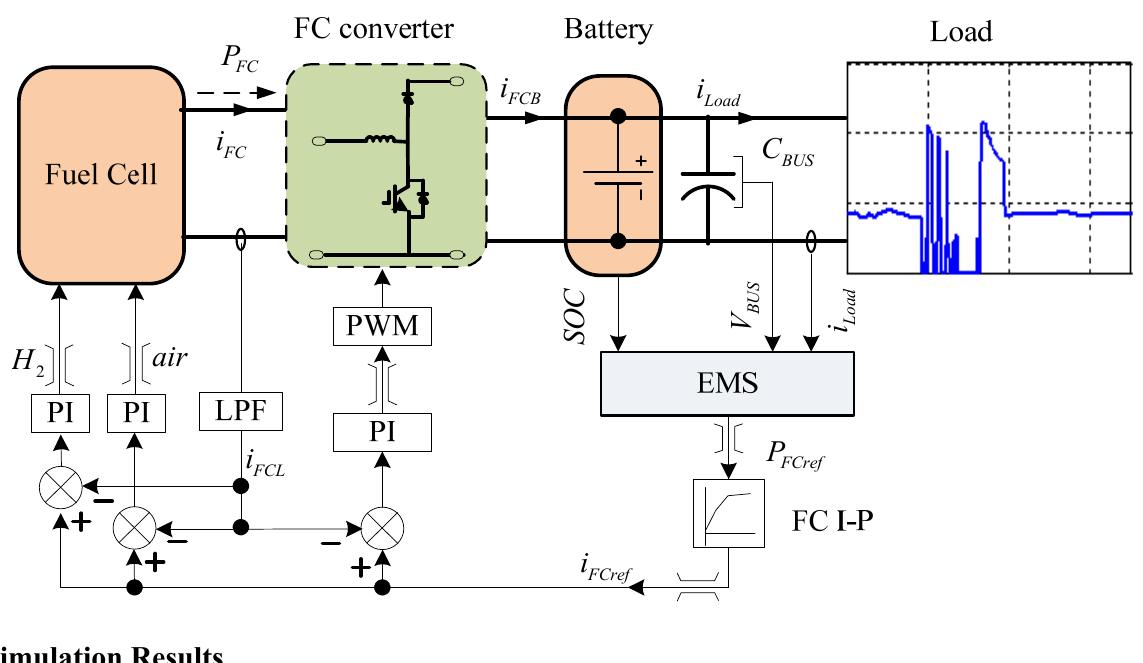
Figure 10. Model of the hybrid system. PWM: pulse width modulation; LPF: low-pass filter; PI: proportional-integral controller; and EMS: energy management